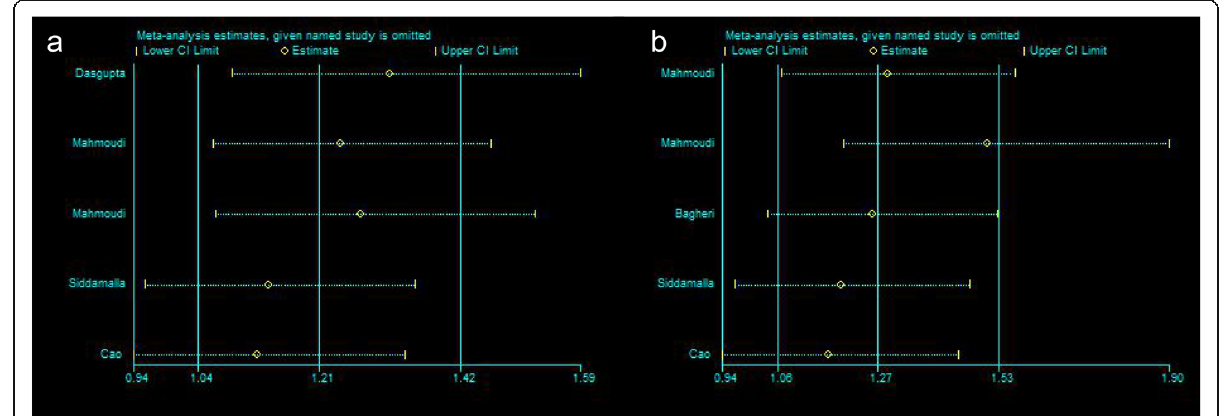
Fig. 4 Sensitive analysis by omitting one study at a time to evaluate the stability of results. a VDR ApaI (rs7975232) with allelic model: C vs. A; b VDR BsmI (rs1544410) with allelic model: G vs.